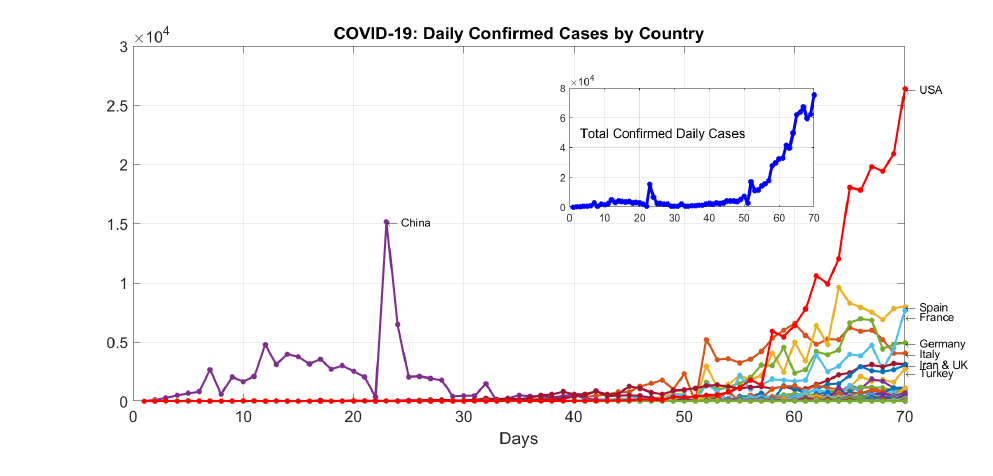
Figure 5. Number of daily confirmed cases by country of COVID-19 from 22 January to 31